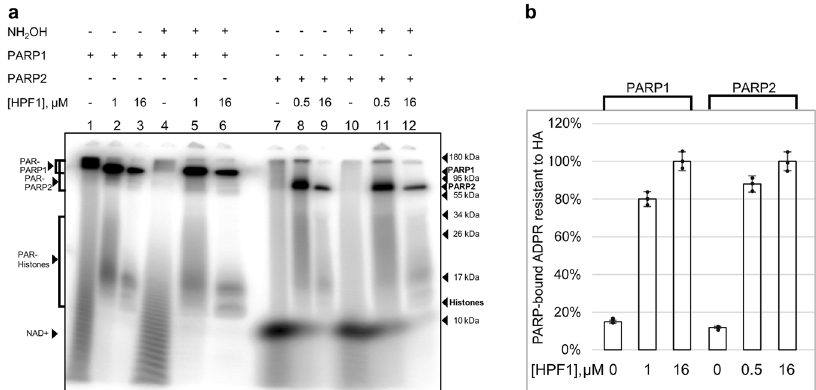
Fig. 5 The HPF1-induced switch of the amino acid speci fi city of ADP-ribosylation depends on the HPF1 concentration. a Autoradiogram shows covalent binding of 32 P-labelled ADP-ribose to PARP1/PARP2 after 30 min incubation of PARPs (500 nM) with [ 32 P]NAD + (1 μ M) in the absence and presence of indicated HPF1 concentrations with and without treatment with 1 M HA and further separation of products in 20% SDS-PAG. b Histograms present portion of HA-resistant modi fi cation (the mean ± SD of three independent measurements and individual data points) determined by normalization of the protein- incorporated ADP-ribose (ADPR) amount in the HA-treated sample to that in the respective untreated sample.